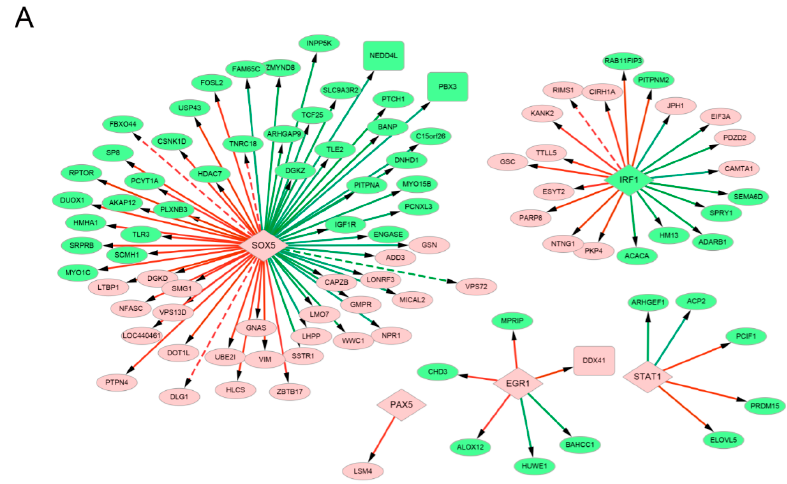
Figure 2. Cont . Figure 2.